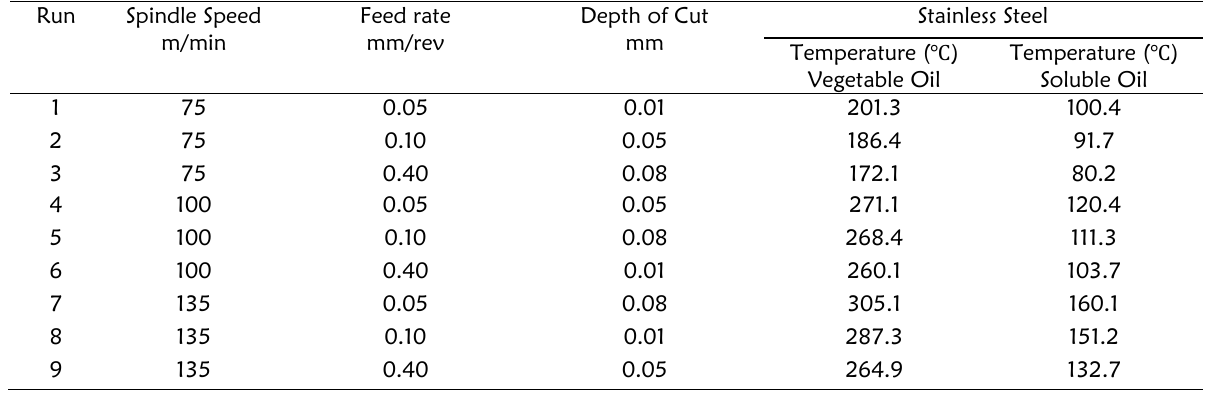
Table 6: Temperature Obtain at Various Machining Condition